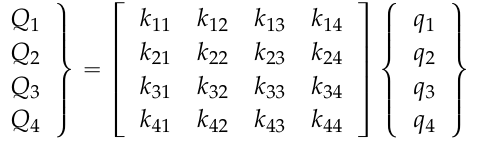
1 “ 1; ( b ) AB in deformation q 2 “ 1;